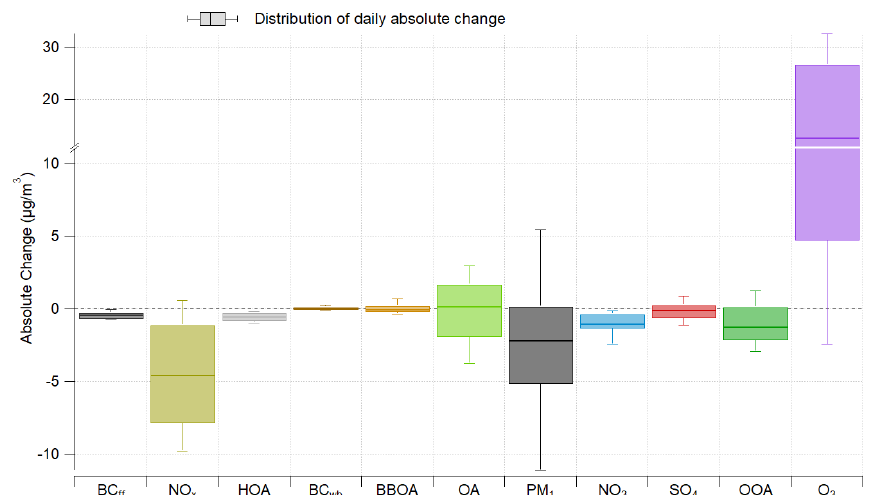
Figure 4. Absolute changes of ambient concentrations of reactive gases and particulate pollutants due to lockdown. Box plots represent the distribution of daily absolute change (µg/m 3 ); 10th, 25th, 50th, 75th and 90th percentiles were used. Values are presented in Table 5.